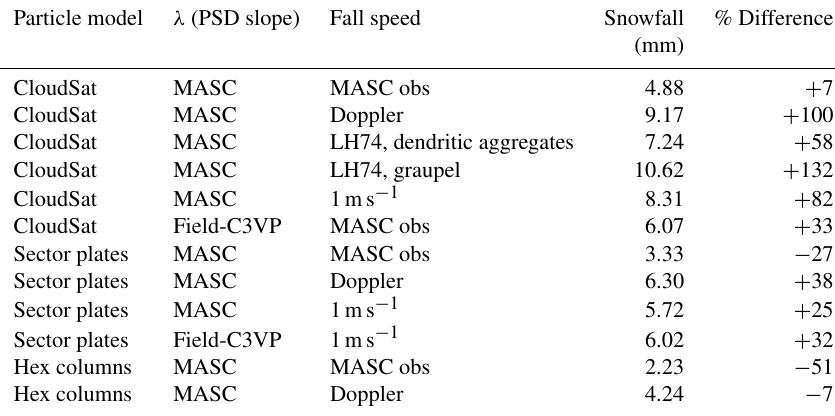
Table 2. Retrieved snowfall amounts for a 23 April snow event for designated retrieval assumption combinations. Nearby NWS observations suggested 4.57mm (0.18 inches) of snowfall liquid equivalent. The MASC-derived PSD slope parameters ( λ ) used for this event are listed in Table